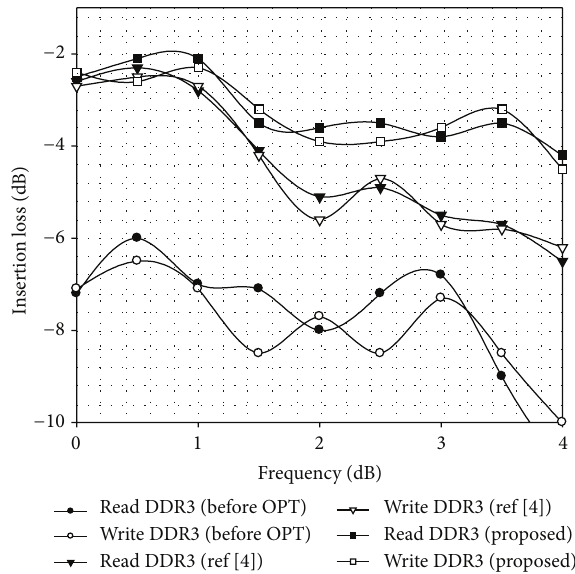
Figure 7: Simulation results for frequency domain.